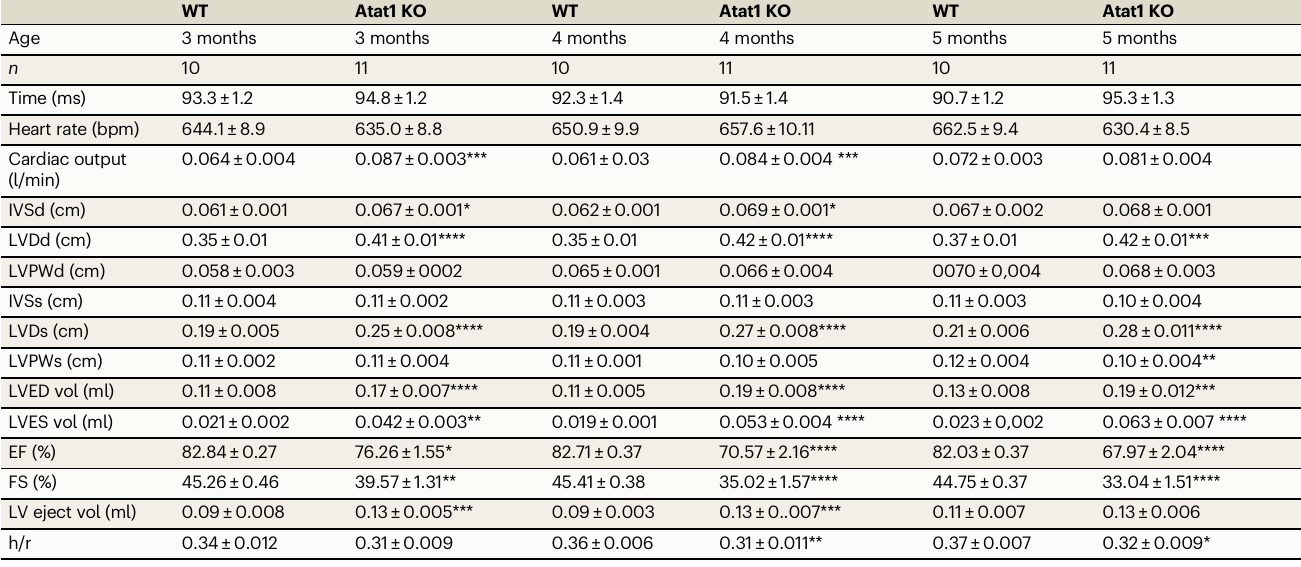
Table 1 | Echocardiographic data for Atat1 +/+ (WT) and Atat1 − / − (Atat1 KO) mice at 3; 4 and 5 months of